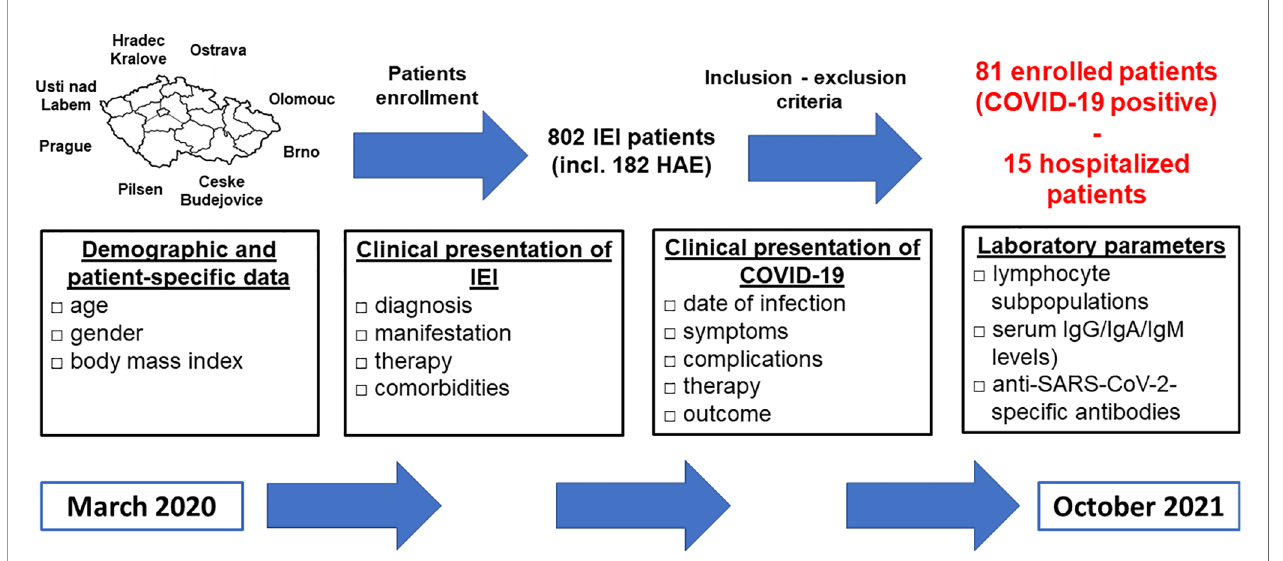
FIGURE 1 | Study design - participating centers, enrollment process, study (data collection) period and extent (characteristics) of collected data are shown (IEI, inborn errors of immunity; HAE, hereditary angioedema; Ig,